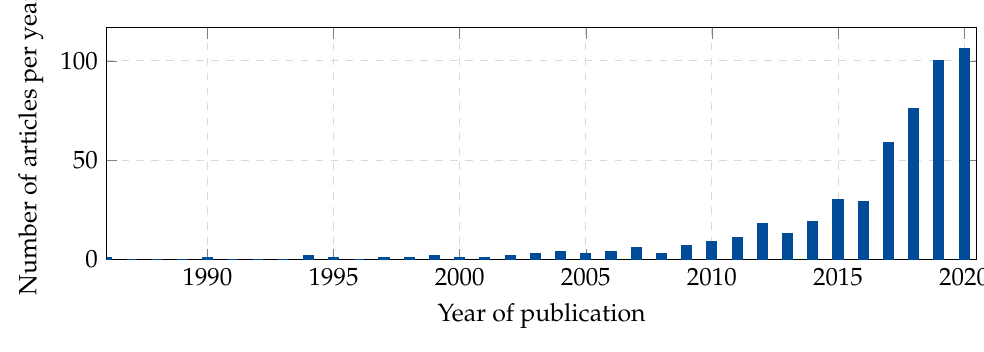
Figure 2. Number of papers per year addressing scene prediction (based on